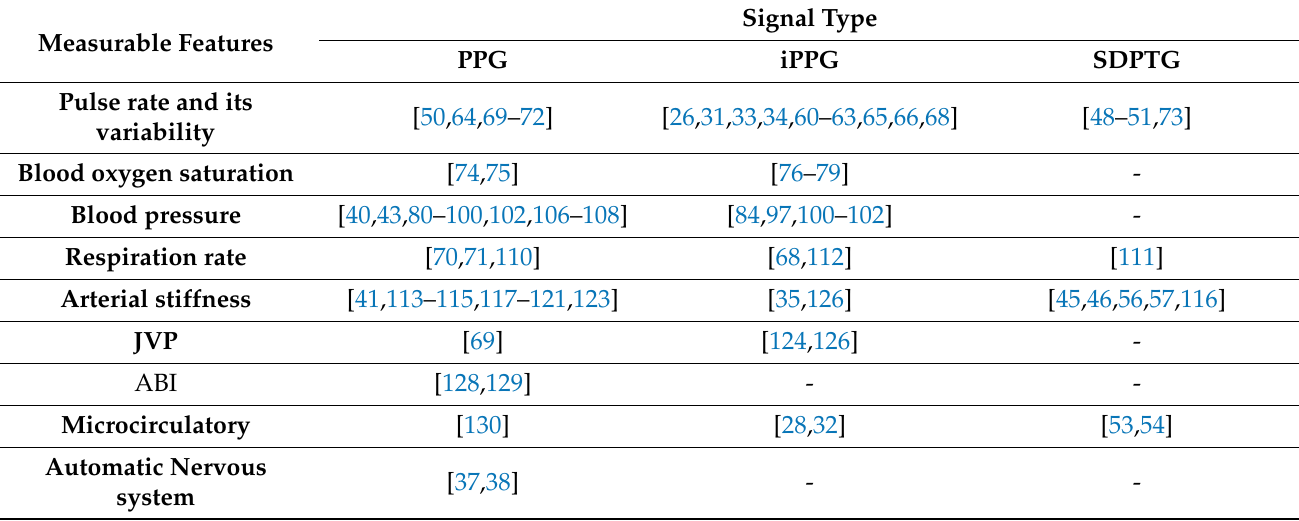
Table 2. Measurable diagnostic features based on different PPG